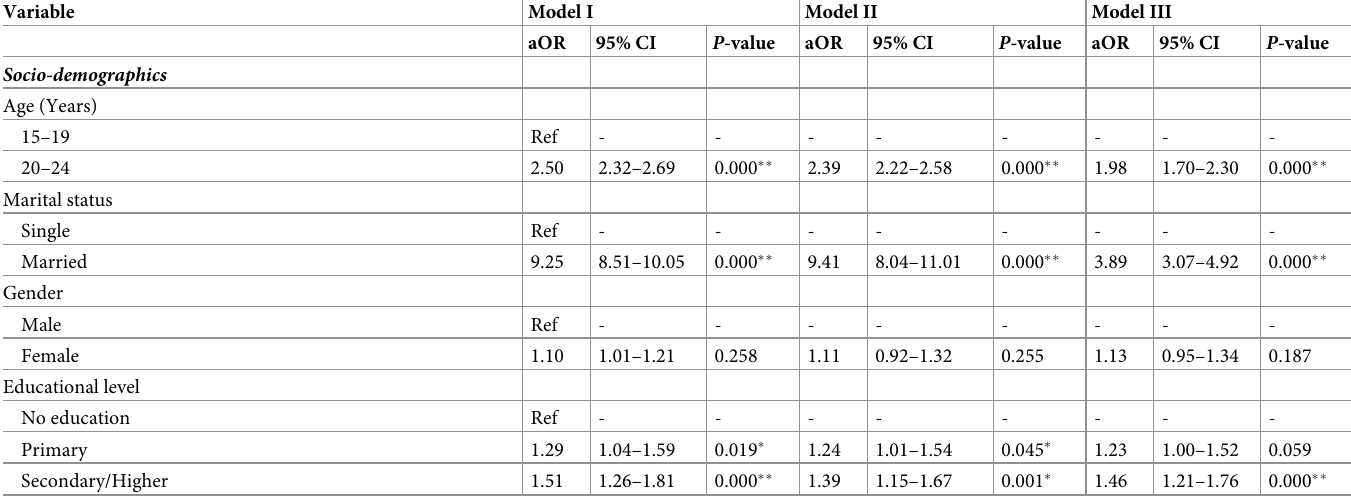
Table 3. Multivariate hierarchical logistic regression of HIV testing (n = 6194).